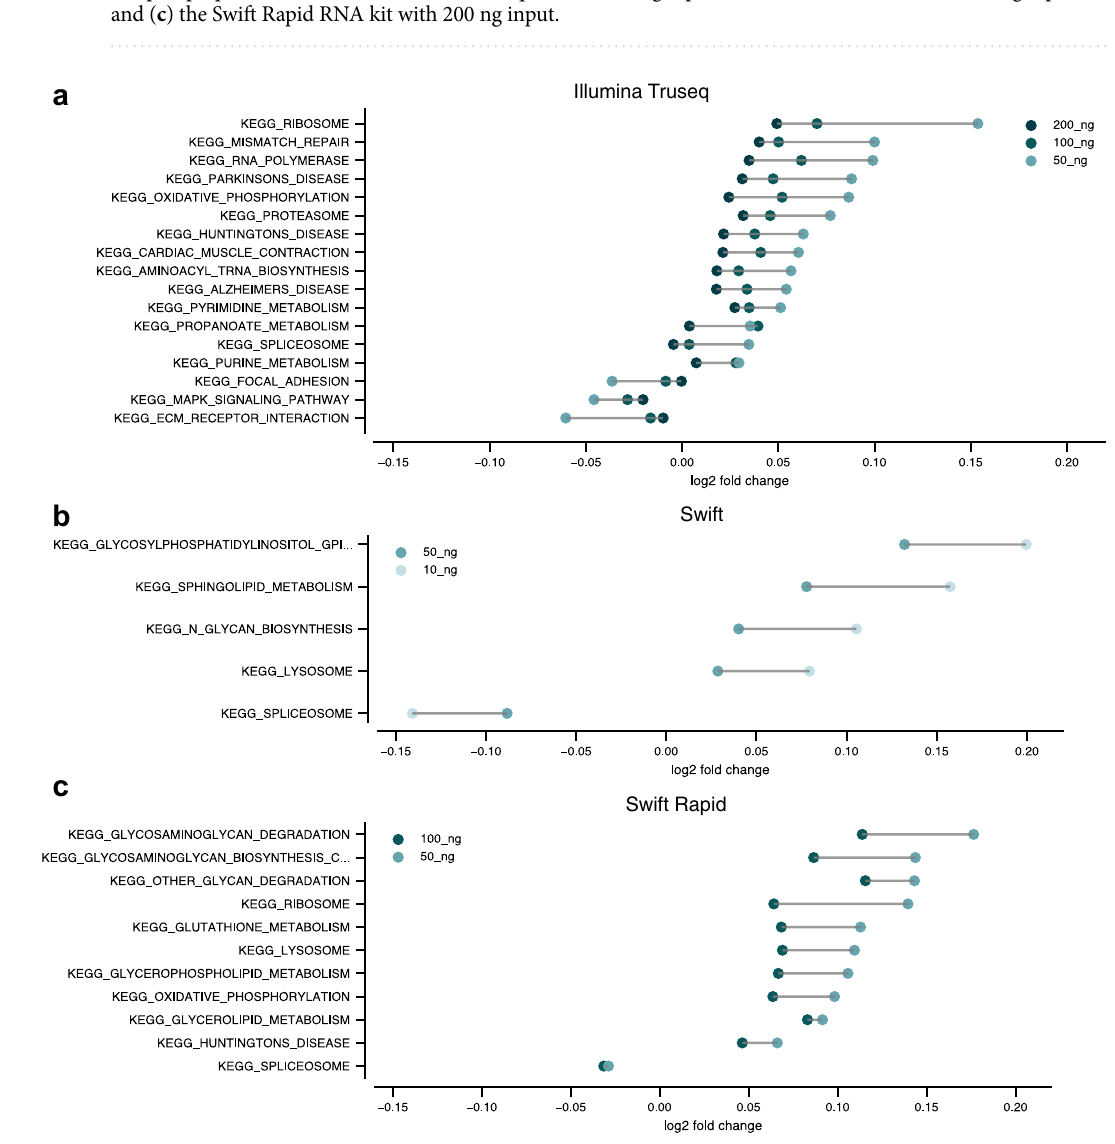
Figure 7. Comparison of differential pathway expression results. Average log 2 fold change of genes in differentially expressed KEGG pathways at the p = .01 significance level (at any input amount) depends on library preparation method and input. Differential expression computed with respect to reference samples prepared with ( a ) the Illumina TruSeq kit with 500 ng input, ( b ) the Swift RNA kit with 100 ng input, and ( c ) the Swift Rapid RNA kit with 200 ng